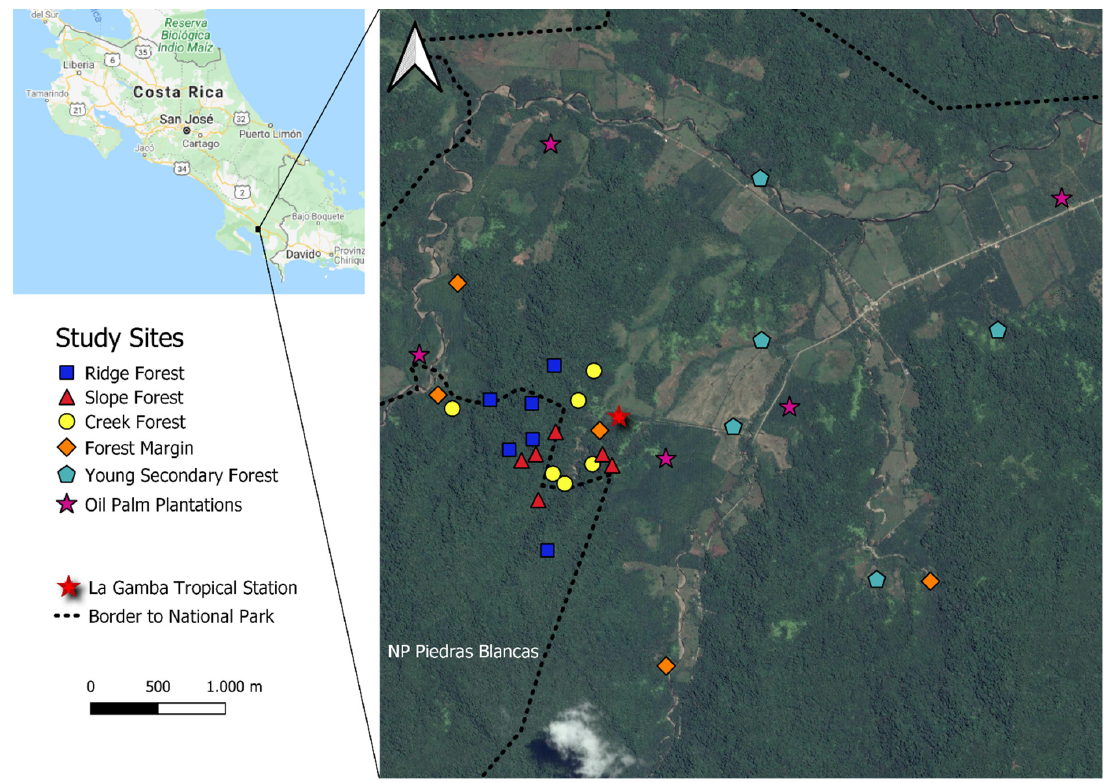
Figure 1. Schematic map showing the location of 38 light-trapping sites in the vicinity of the La Gamba Field Station, SW Costa Rica (8°43 ′ N, 83°13 ′ W).